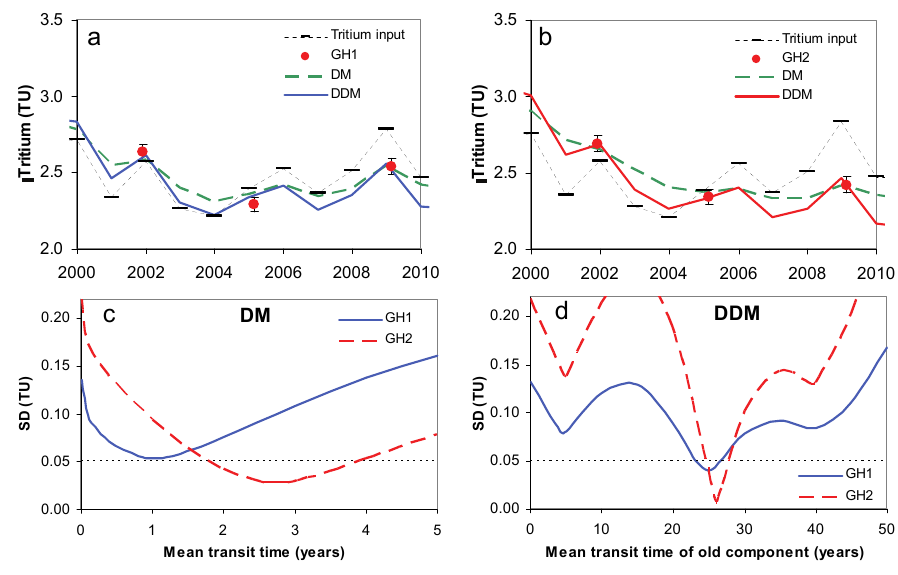
Fig. 5. Tritium measurements and simulations for stream sites GH1 and GH2. Variation of the quality of fit (sd) with mean transit time for the DM, and mean transit time of the old component for the DDM. The dotted line shows the measurement error (0.05 TU).